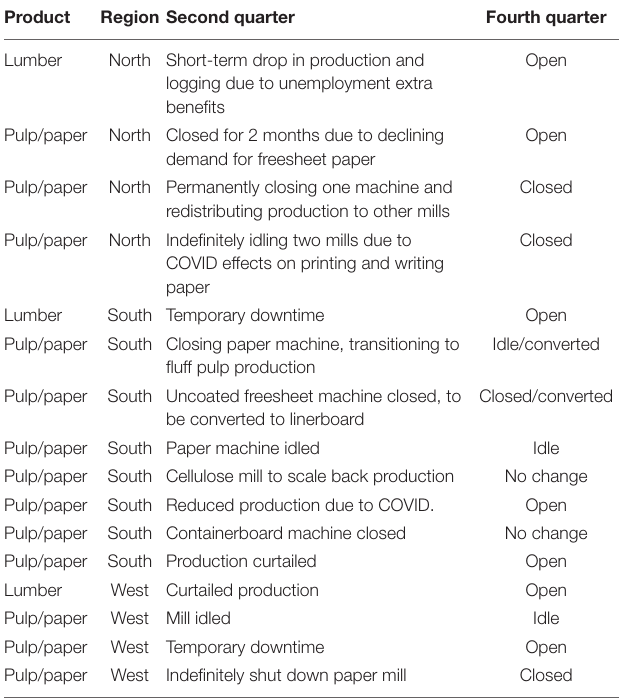
TABLE 5 | Mill closures in the United States due to the COVID-19 pandemic. Product Region Second